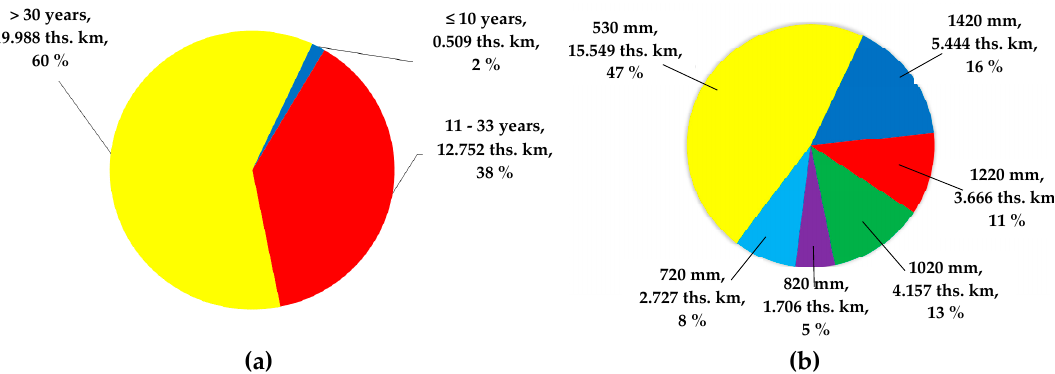
Figure 3. Structure of the system of gas mains and branches of Ukrtransgas PJSC (ths. km and %) in terms of the period of operation (a) and diameters (b).